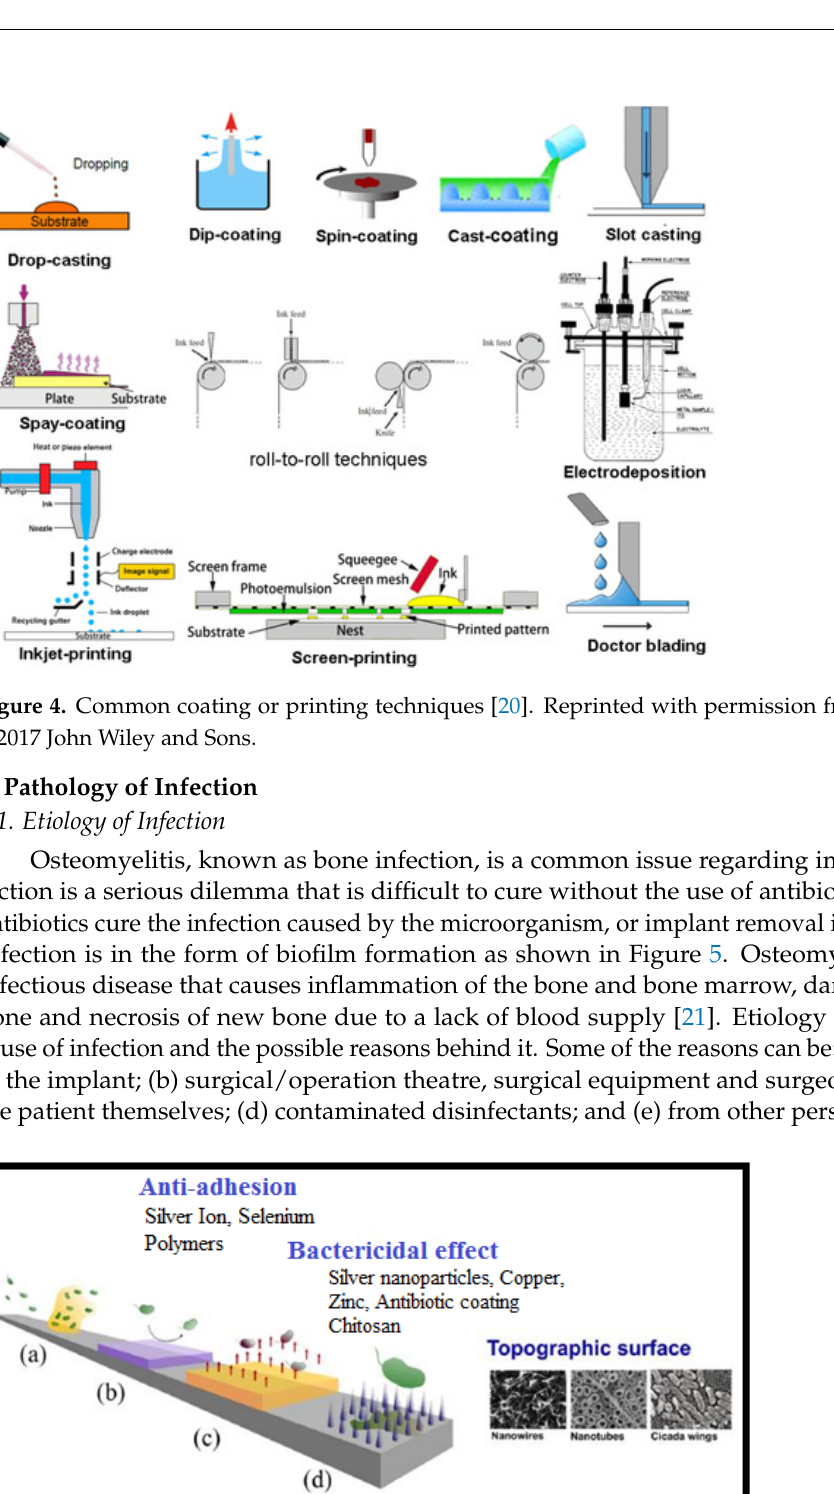
Figure 5. Planktonic bacteria forming a biofilm on the material surface: ( a ) Antibacterial strategies based on ions and polymer coatings ideas of surface chemistry and functionality were employed in a variety of ways; including ( b ) the surface of the material, which can be coated with bactericidal chemicals such as antibiotics and silver ( c ) Surface nanotopographic alterations utilized as anti- adhesives or bactericidal agents. ( d ) Nanotopography examples, such as nanowires, nanotubes, and cicada wings [23]. Adapted with permission from ref. [23]. A 2018 Creative Commons Attribution (CC BY)